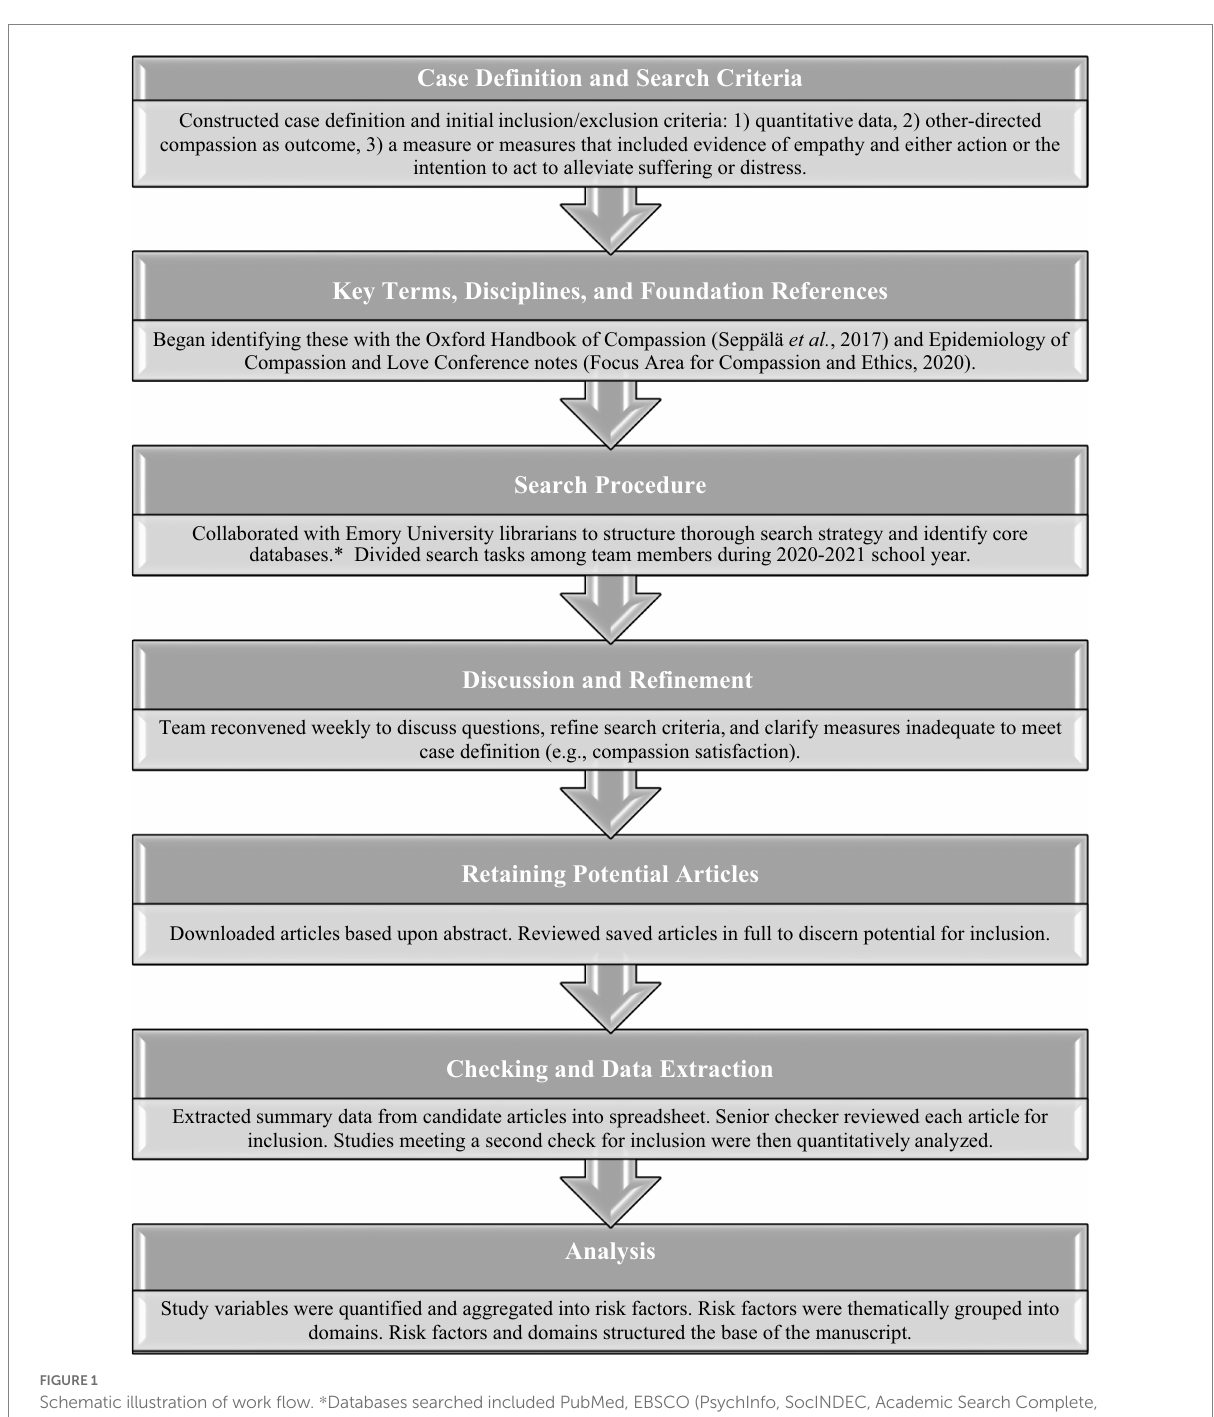
FIGURE 1 Schematic illustration of work flow. * Databases searched included PubMed, EBSCO (PsychInfo, SocINDEC, Academic Search Complete, Encyclopedia of Religion and Philosophy), JSTOR, Scopus, Web of Science, Sociological Abstracts, Social Sciences Full Text, CAB Direct, and Google